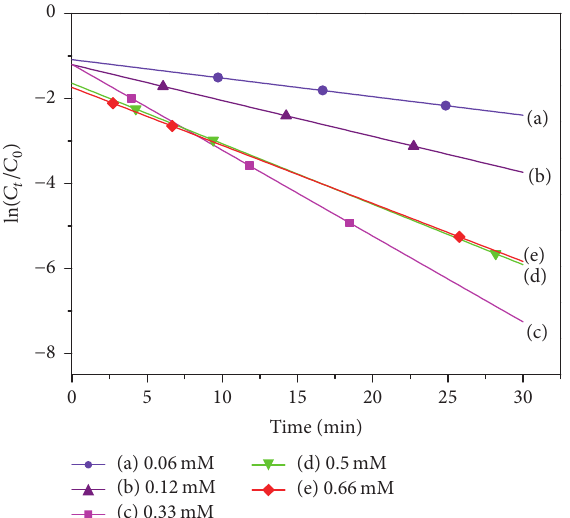
Figure 6: Kinetic for decomposition of bromothymol blue with GZVINPs concentration of (a) 0.06 mM, (b) 0.12mM, (c) 0.33 mM, (d) 0.5 mM, and (e) 0.66 mM.